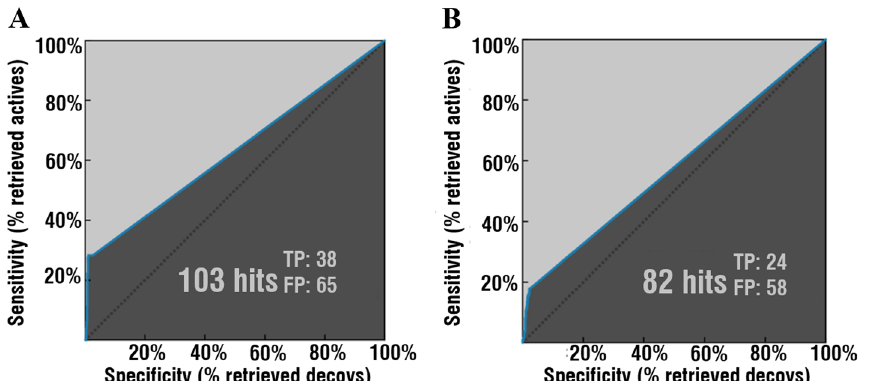
Figure 4. Validation of the generated structure-based pharmacophore on the two datasets ( A , B ). Identified hit compounds out of 2635 total compounds (135 actives, 2500 decoys). Figure was obtained using LigandScout v4.4 27 (www. intel igand. com/ ligan dscout/). Schematic illustration was drawn using Adobe Illustrator 2018 (www. adobe. com/ produ cts/ illus